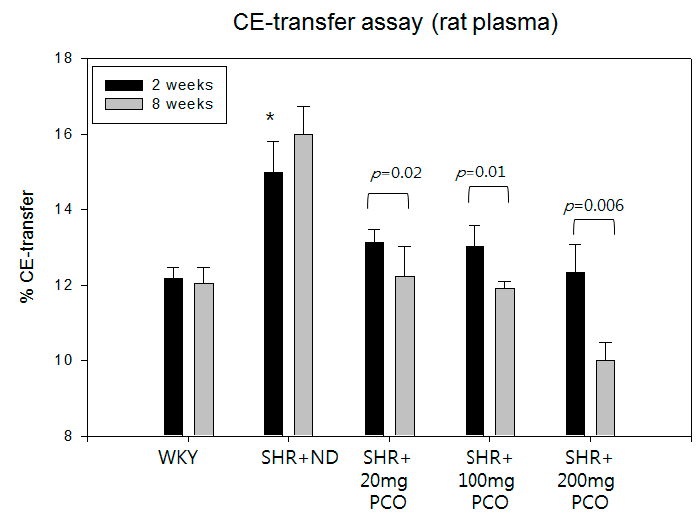
Figure 4. CE-transfer activity of WKY rats and SHR plasma after eight weeks of policosanol supplementation. Data shown are the mean ± SD of three independent experiments performed in duplicate. CE-transfer from [ 3 H]-HDL (50 µg of apoA-I, 30,000 CPM) to human LDL (50 µg of protein) by rat plasma.